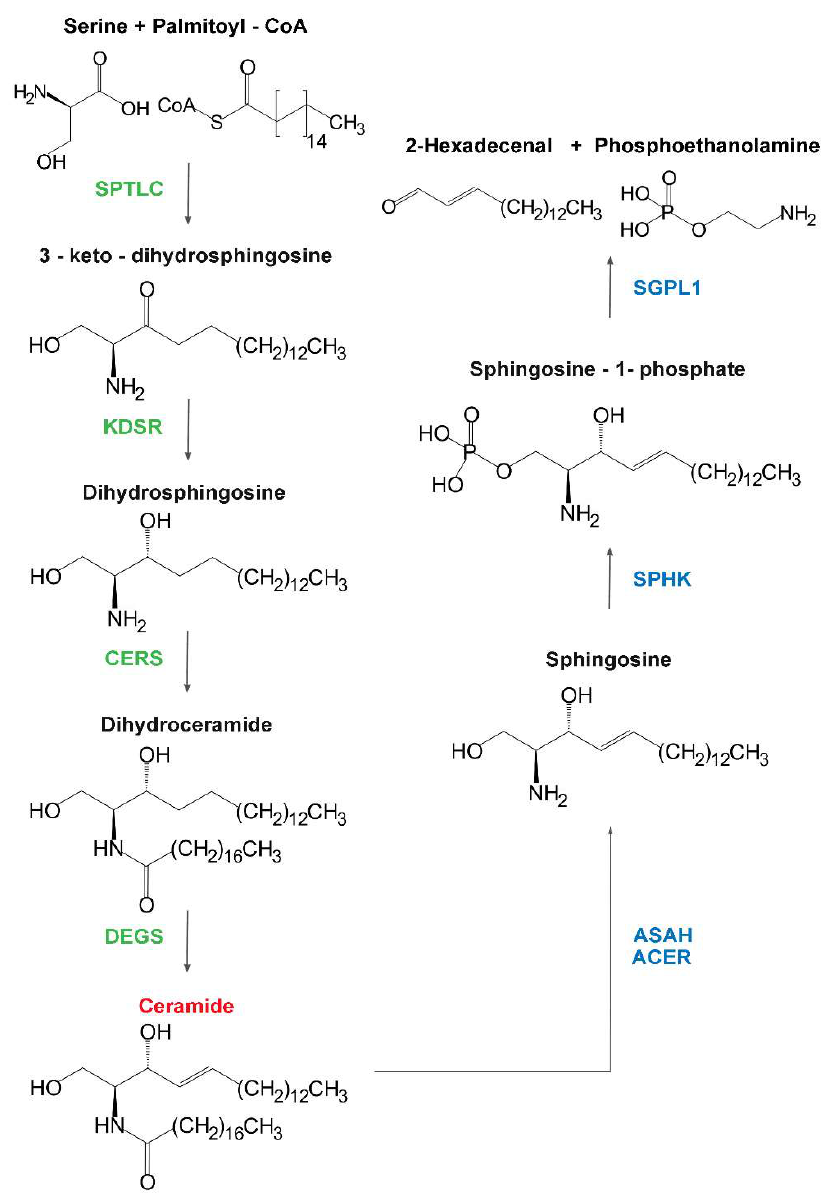
Figure 1. Biosynthesis and degradation of ceramide. SPTLC, serine palmitoyl transferase; KDSR, 3-keto-dihydro-sphingosine reductase; CERS, dihydroceramide synthase; DEGS, dihydroceramide desaturase; ASAH, acid ceramidase; ACER, alkaline ceramidase; SPHK, sphingosine kinase; SGPL1, sphingosine lyase. For simplicity, only stearic acid is depicted as the acyl chain of ceramides, but longer fatty acids can be added by different CERSs.